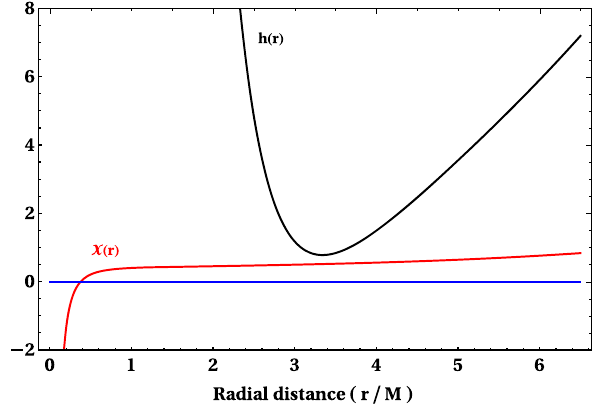
Fig. 3 A black hole with only event horizon and free of cosmological horizon as well as singularity